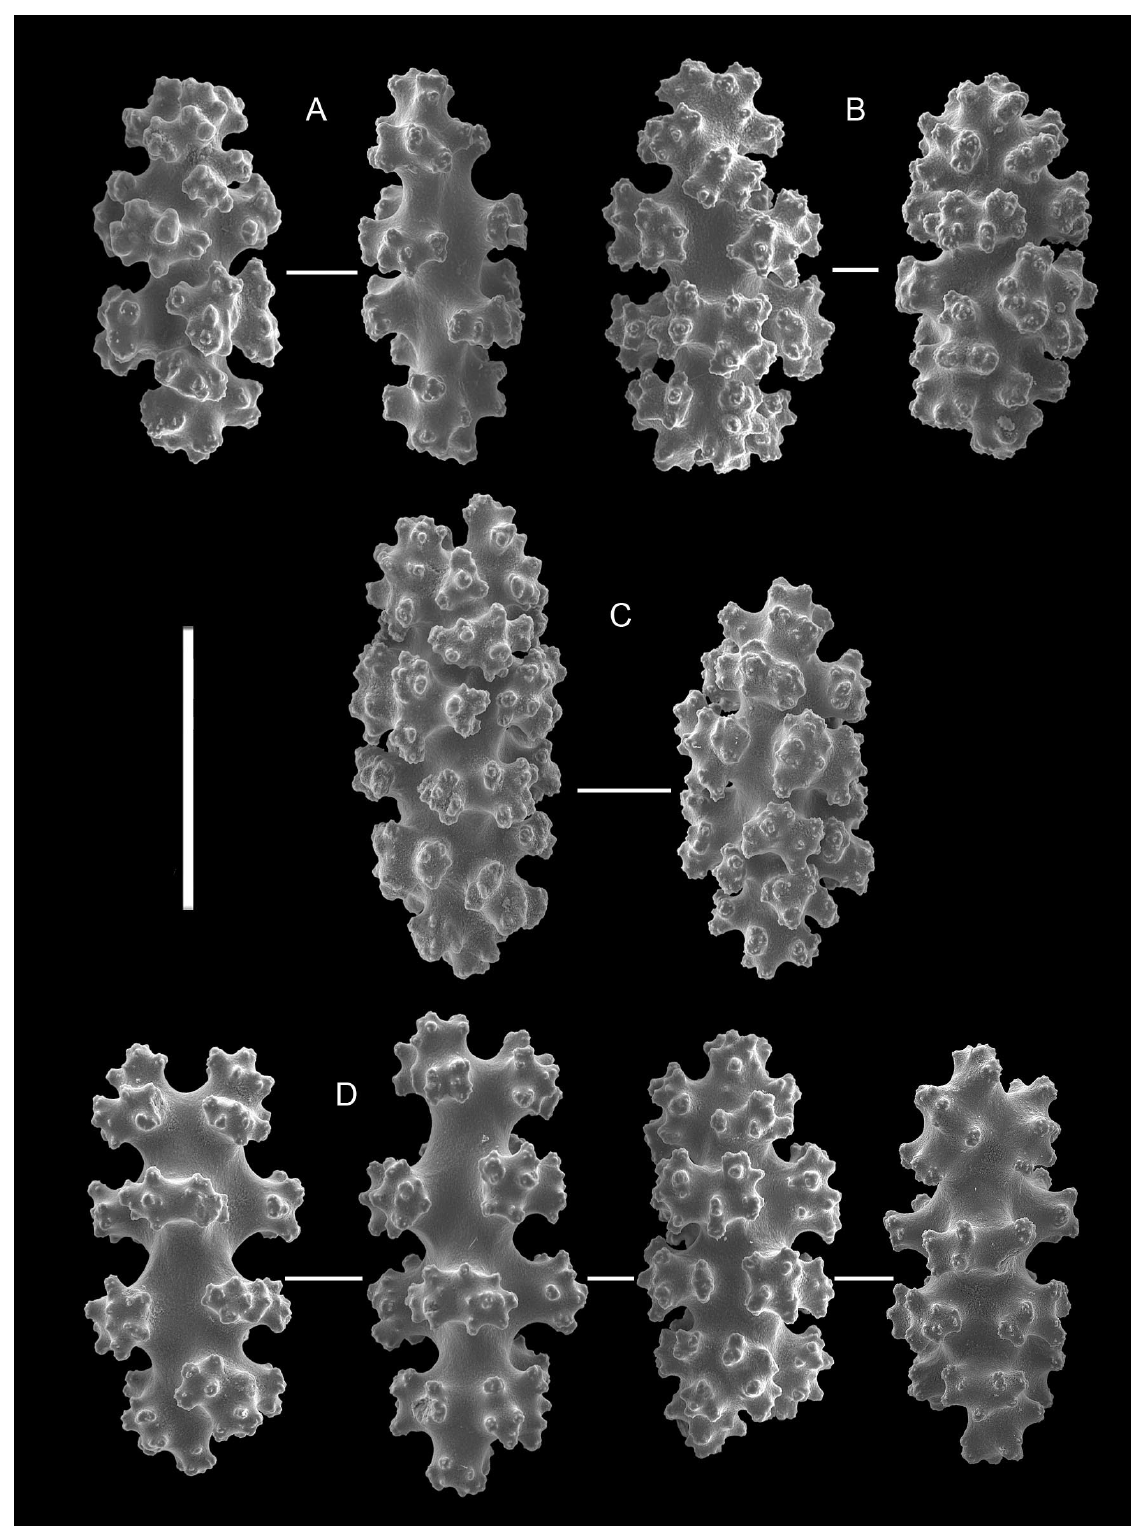
Fig. 12. Calcigorgia lukini sp. nov., paratype MIMB 20712, sclerites A . Capstans from polyp body wall. B . Well calcified capstans (8-radiate) from polyp body wall. C . Ovals from polyp body wall. D . Capstans (8-radiate) from the coenenchyme. Scale bar = 0.1